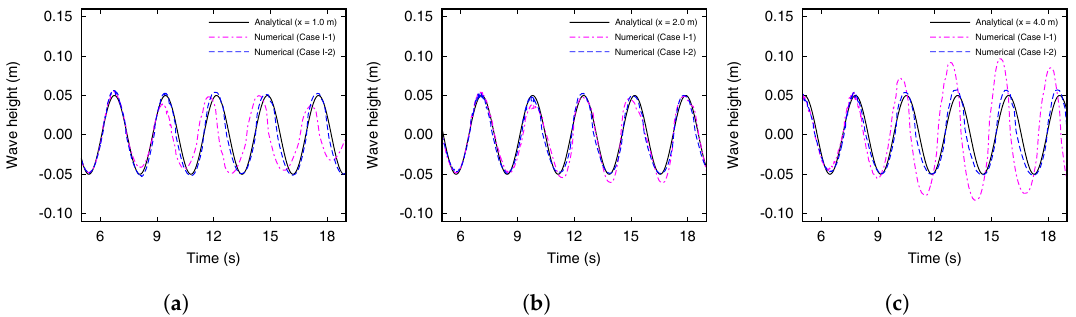
Figure 3. Comparison of the numerical and analytical wave heights ( a ) at x = 1.0 m, ( b ) x = 2.0 m, and ( c ) x = 4.0